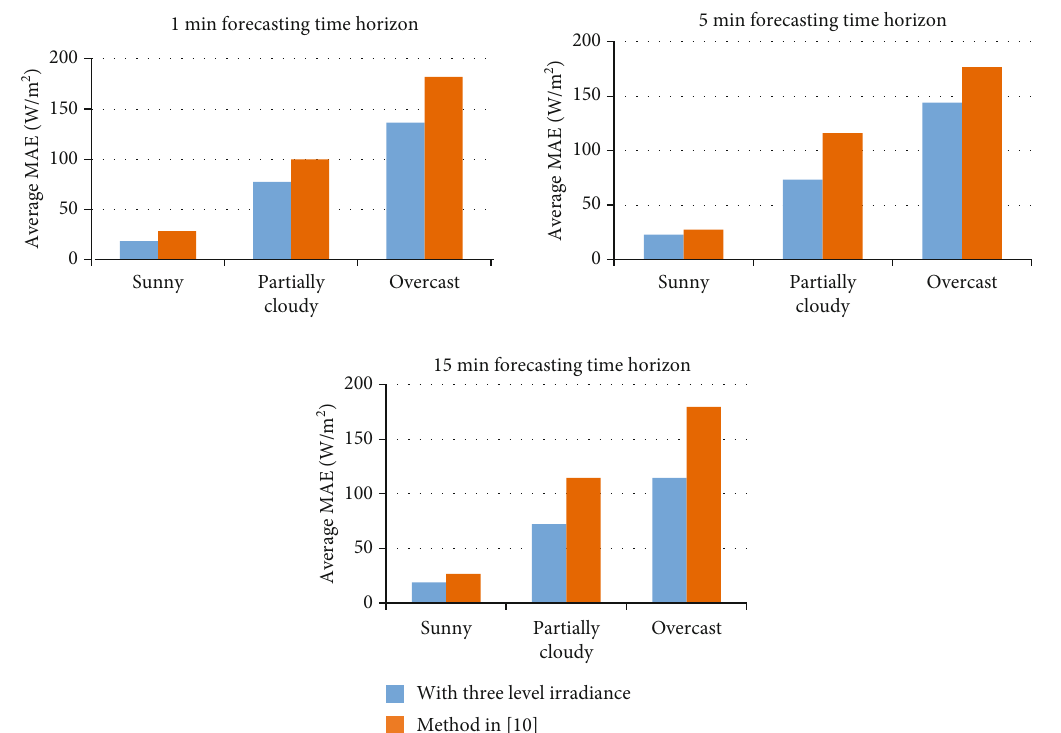
Figure 20: Comparison of average MAEs obtained for the three-level cloud categorization and single drop level assumption (40% drop) and for the forecasting model introduced in [10]. Table 5: Comparison of average RMSE. Method Irradiance mapping methods trained using BPNN [33]